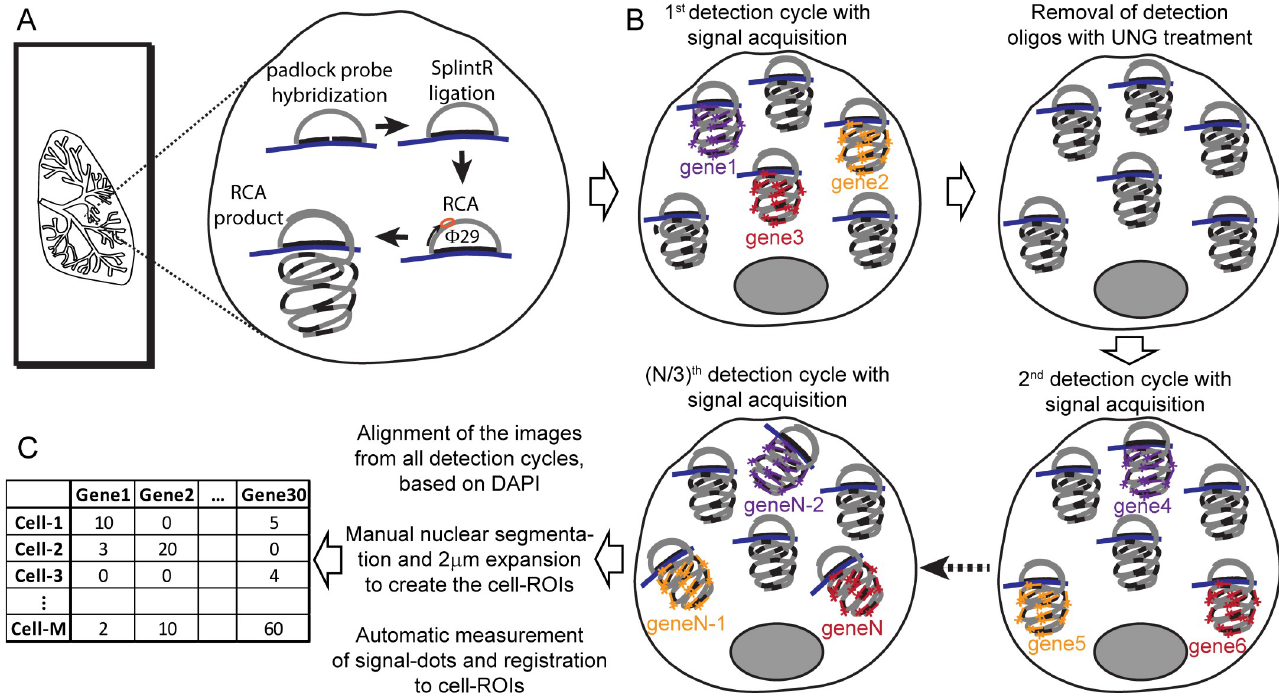
Fig 1. Schematic representation of SCRINSHOT. The major steps of the assay are (A) all padlock probe hybridization for all the targeted RNA species followed by ligation and RCA-amplification. (B) RCA-products are detected sequentially reading 3 per cycle, with FITC-, Cy3-, and Cy5-labeled detection oligos, which recognize the gene-specific part of the padlock probes. (C) Images from all detection cycles are aligned using DAPI nuclear staining and segmented to create the cell ROIs, and signal dots are counted and registered to the cell ROIs. RCA, rolling circle amplification; ROI, region of interest; UNG, uracil-N-glycosylase; φ 29, Bacillus subtilis phage phi29 DNA